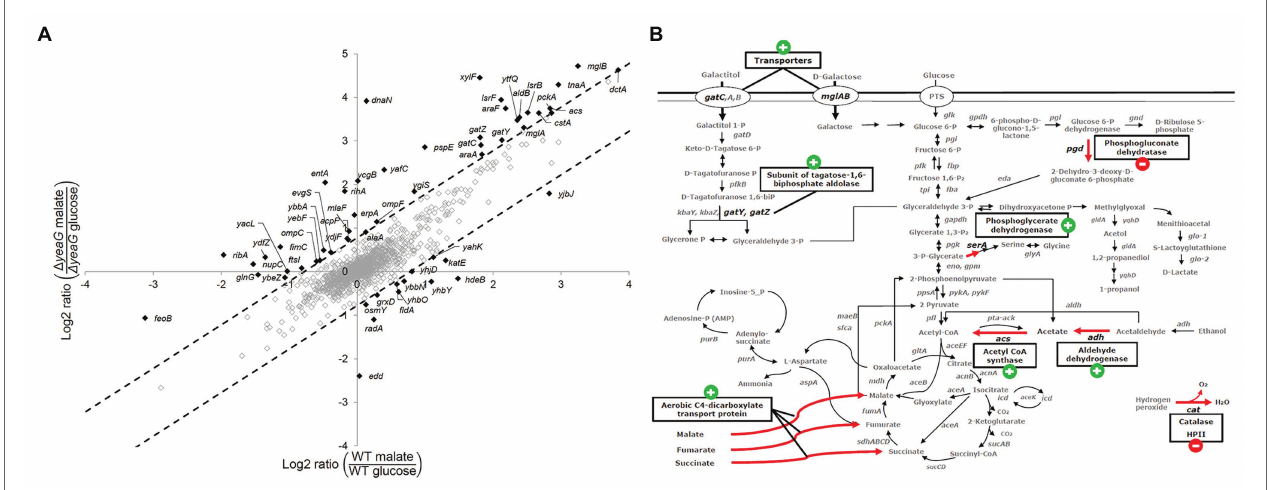
FIGURE 2 | Differential expression of proteins during glucose to malate shift. (A) Plot of quantified protein ratios (in response to shift in carbon source from glucose to malate) for the Δ yeaG vs. the wild type strain. As a cutoff for assigning proteins differentially regulated in the two strains, we chose to use two SDs from the mean of the dataset (indicated by dotted lines). Proteins that were differentially upregulated or downregulated are marked in black and gene names are shown. (B) Proteins that are differently regulated during malate shift in the wild type and Δ yeaG strains mapped on the central carbon metabolism of E. coli K-12 MG1655. Red arrows are used to highlight metabolic and transport reactions catalyzed by the affected enzymes. The expression change during glucose to malate shift in Δ yeaG compared to the wild type strain is indicated next to the enzyme name by a plus/minus